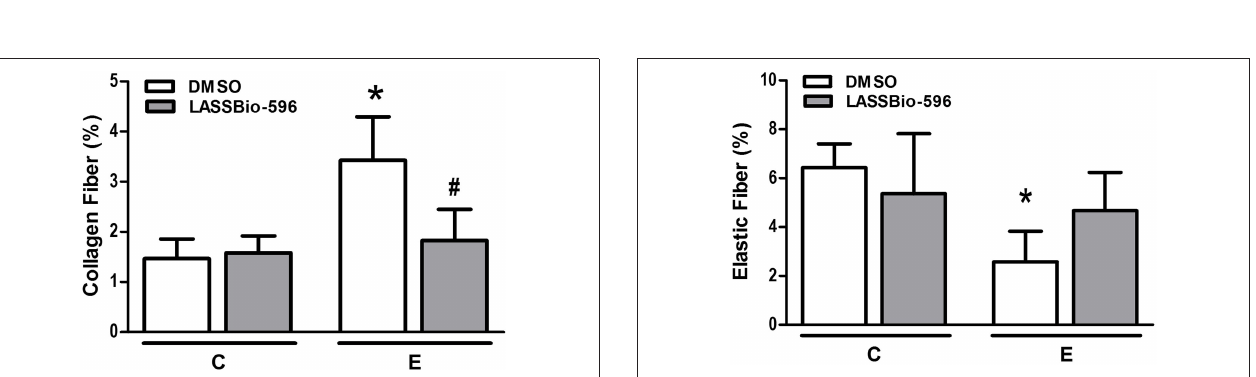
FIGURE 5 | Immunohistochemical analysis for the M1 (A) and (B) M2 macrophage phenotypes in lung tissue. Values are means ( ± SD) of six animals in each group. C-DMSO: mice received intratracheal saline and were treated with DMSO. C-LASSBio-596 mice received intratracheal saline and were treated with LASSBio-596. E-DMSO: mice received intratracheal porcine pancreatic elastase and were treated with DMSO. E-LASSBio-596: mice received intratracheal porcine pancreatic elastase and were treated with LASSBio-596. * Significantly different from respective group C ( p < 0.05 ). # Significantly different from E-DMSO ( p < 0.05 ).